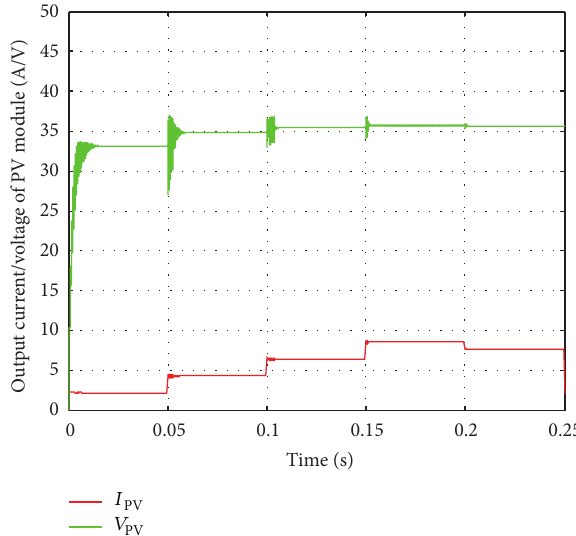
Figure 17: Output current and voltage of PV under variable